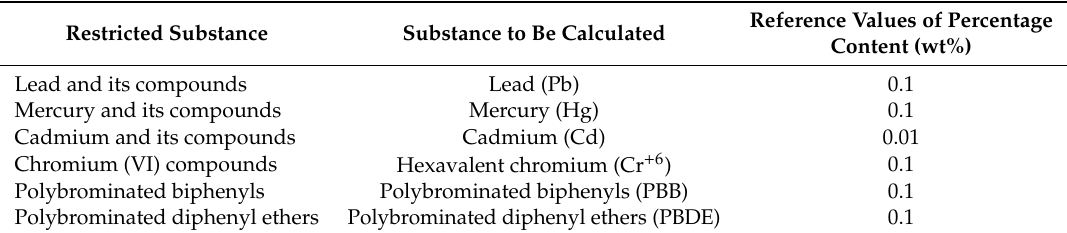
Table 7. The reference values of percentage content for the restricted chemical substances promulgated by the Ordinance CNS 15,663 in